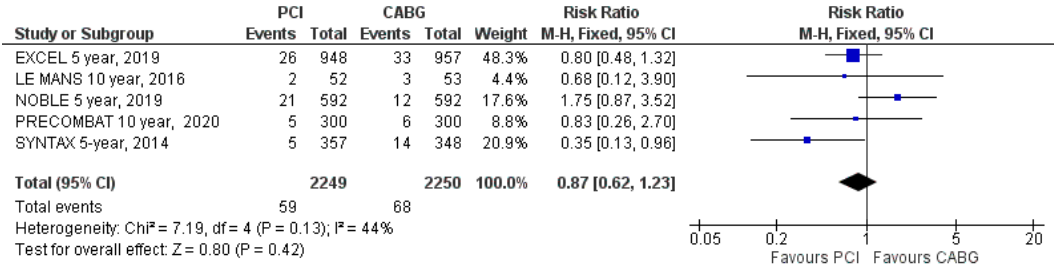
Figure 5. Risk of stroke at the latest follow-up: PCI vs. CABG.